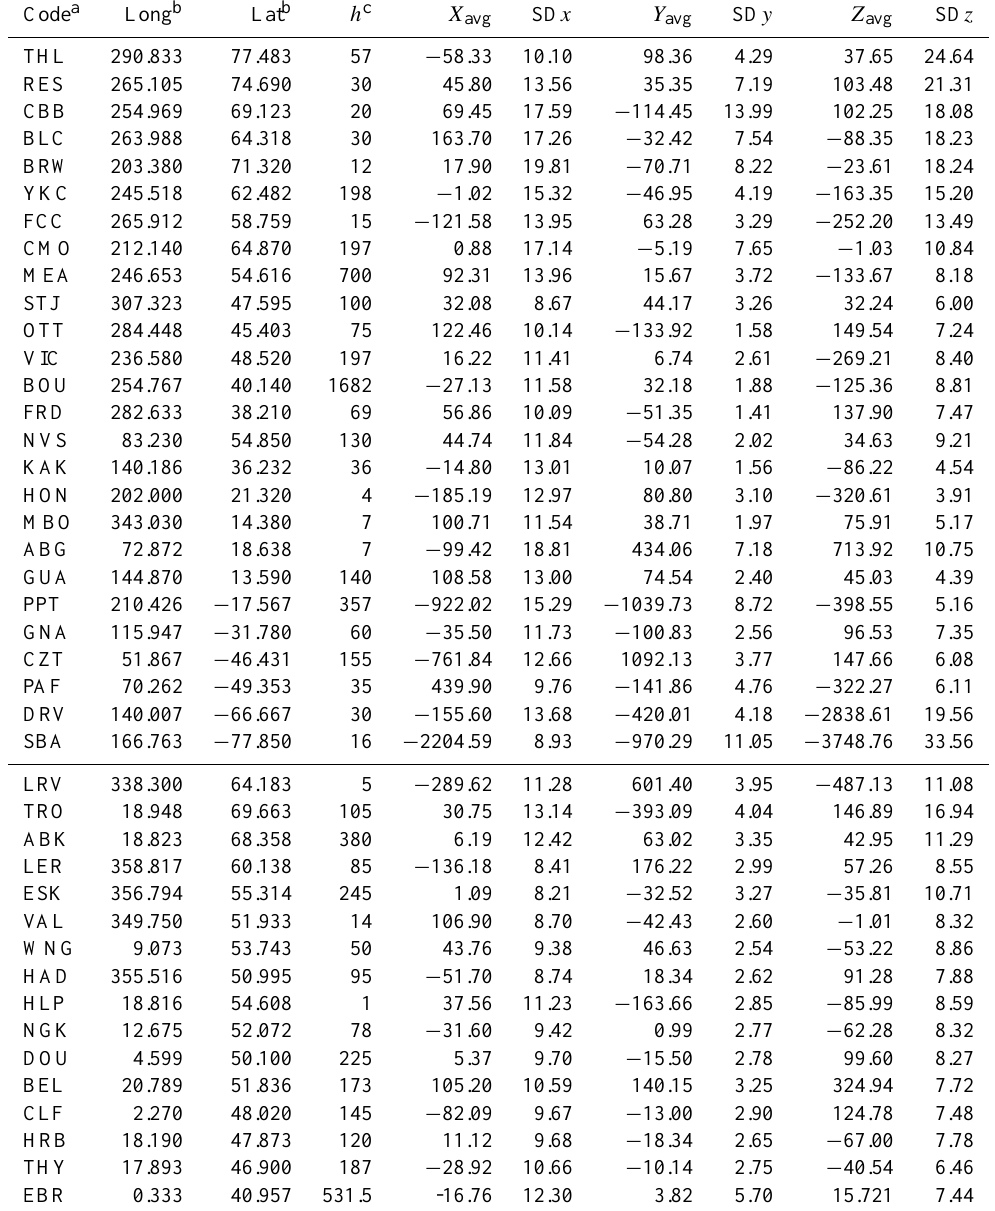
Table 1. Average of the bias over 9 years (June 2000–August 2009) for X , Y and Z components at 42 observatories, in nanoteslas. The solid line separates the non-European from the European